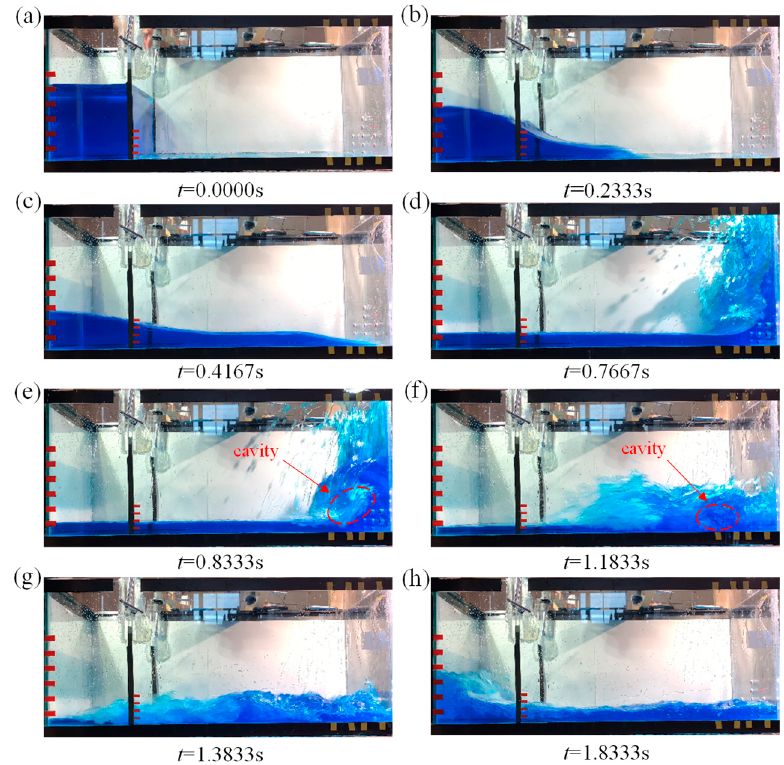
Figure 5. Time series of raw images of the turbulent bore front propagation, impact on a vertical wall, and return wave for a bore generated from an impoundment depth of H = 250 mm: ( a ) t/T = 0; ( b ) t/T = 1.4614; ( c ) t/T = 1.7769; ( d ) t/T = 3.2694; ( e ) t/T = 3.5534; ( f ) t/T = 5.0458; ( g ) t/T = 5.8987; ( h ) t/T = 7.8176.